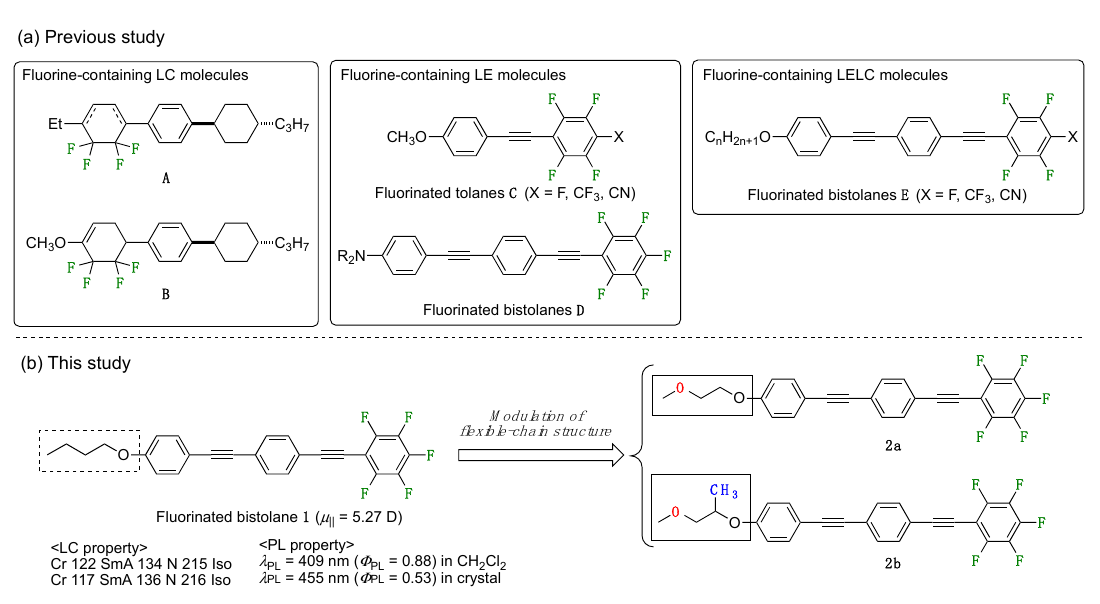
Figure 1. ( a ) Fluorine-containing organic materials developed in our group and ( b ) conceptual illustration of the present study.